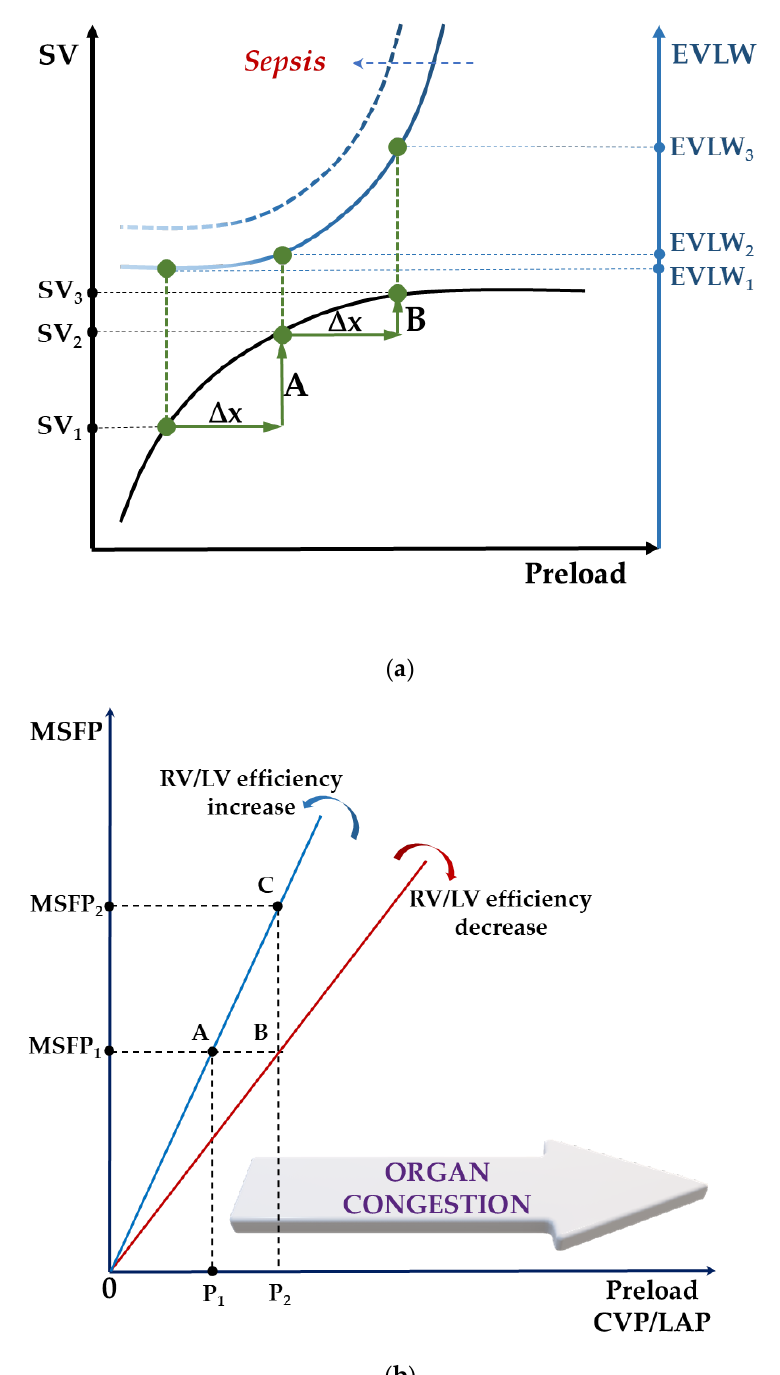
Figure 3. ( a ) A schematic illustration of superimposed Frank–Starling (black) and Marik–Phillips (solid blue) curves demonstrating the effects of an identical preload challenge (∆x) on SV and EVLW in a preload-dependent (A) and preload-independent state (B). A: a steep increase in SV (SV 1 → SV 2 ) with minimal increase in EVLW (EVLW 1 → EVLW 2 ); B: a minimal increase in SV (SV 2 → SV 3 ) with a steep increase in EVLW (EVLW 2 → EVLW 3 ). Sepsis alters the capillary permeability resulting in a leftward shift of the EVLW curve (dotted blue). EVLW, extravascular lung water; SV, stroke volume; ∆x, a specific preload challenge. Adapted with permission [75]. ( b ) A schematic illustration of how ventricular performance (i.e., global RV/LV efficiency) and volume state (i.e., MSFP) interact to produce either increased CVP resulting in extrathoracic congestion (e.g., liver, kidney,